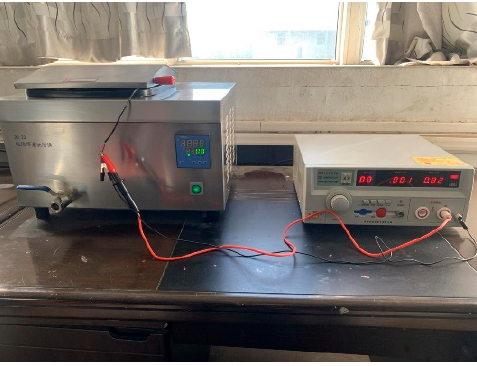
Figure 10. Polarization equipment: temperature-controlled oil bath box, high-voltage DC power supply. Table 1. Polarization process